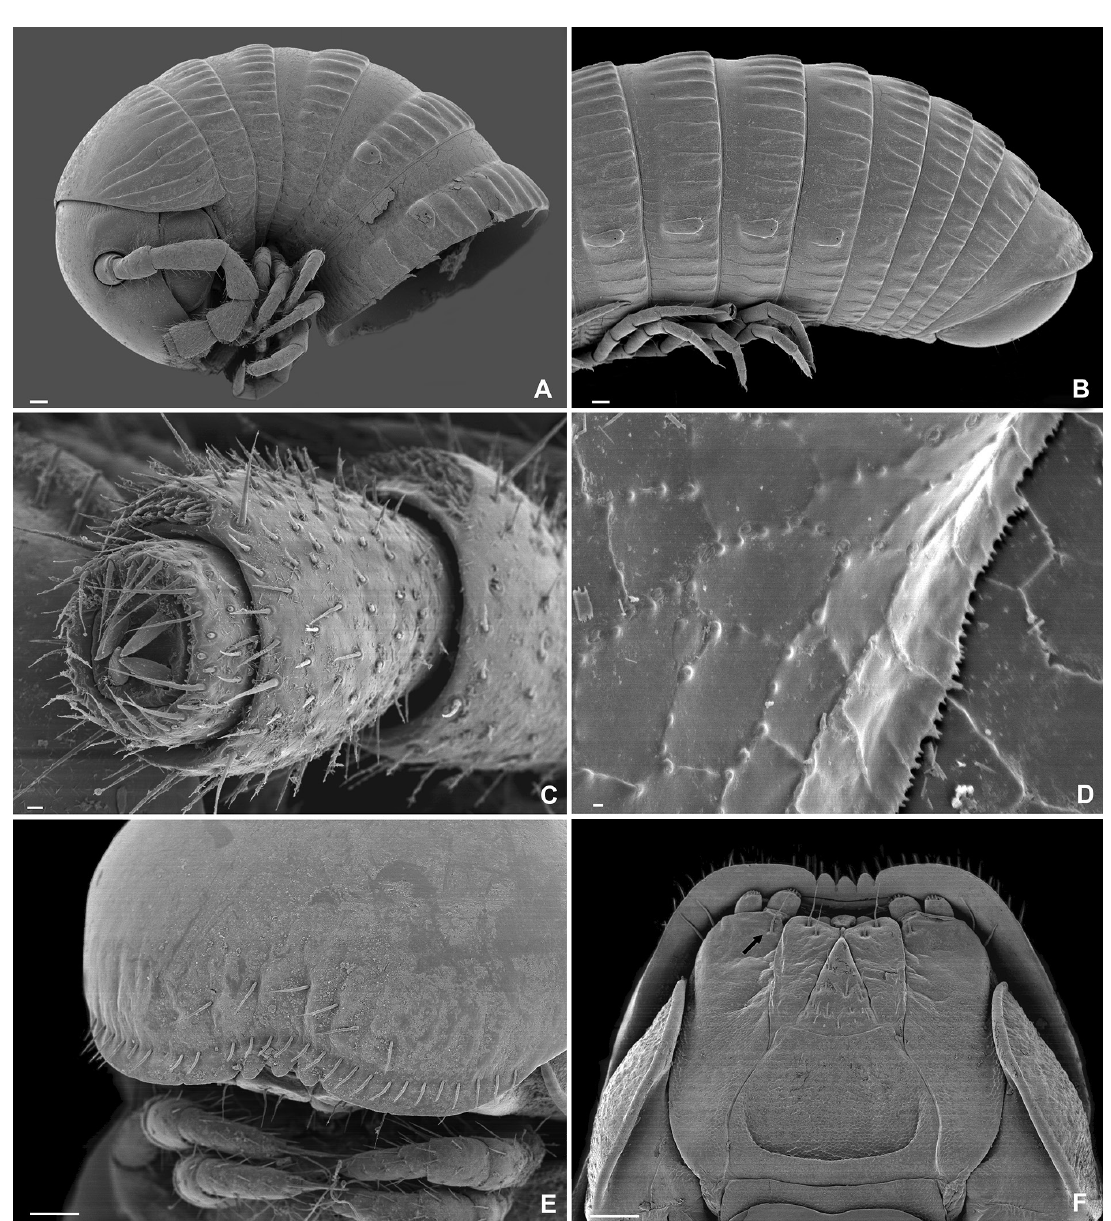
Fig. 3. Chiraziulus kaiseri (Mauriès, 1983), paratypes. Scanning electron micrographs. A . Head and first body rings in lateral view. B . Last body rings (“tail”) in lateral view. C . Tip of antenna. D . Detail of the limbus; notice lines of beadlike structures between cuticular scutes. E . Detail of labrum in frontal view. F . Gnathochilarium in ventral view; the arrow shows the distomesal setae on stipes. Scale bars: A–B, E–F = 100 μm; C = 10 μm; D = 1